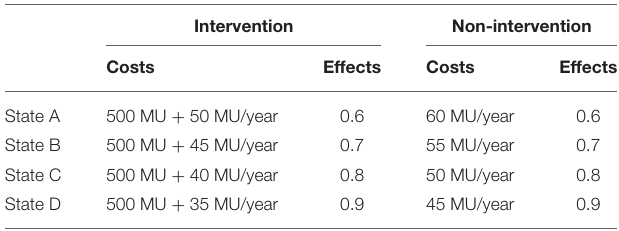
TABLE 3 | Intervention costs.